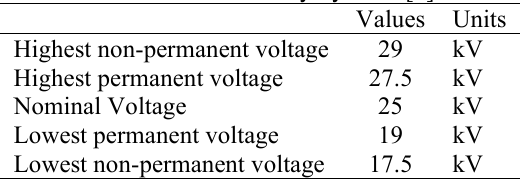
Table 2. Voltage range values allowed in the 25 kV AC electrified railway system [2] .